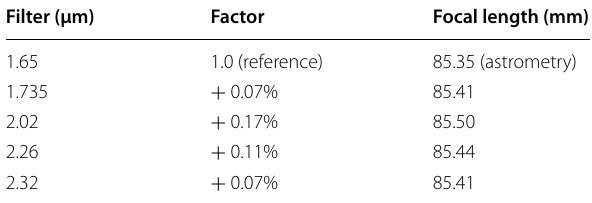
Table 8 Updated focal